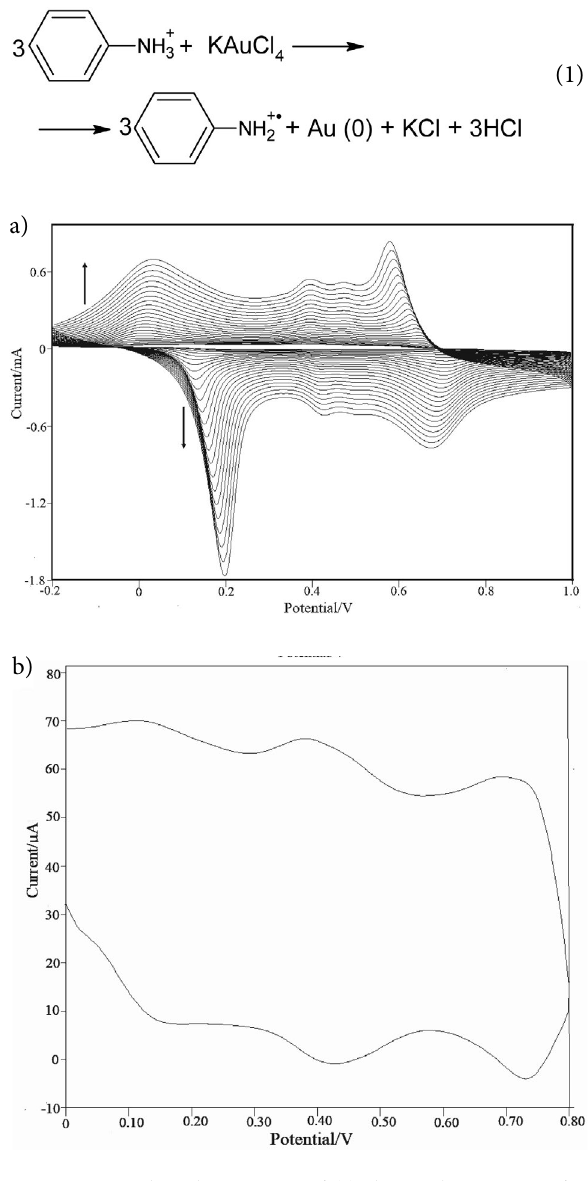
Figure 3. Cyclic voltammogram of (a) electropolymerization of PANI film on Pt electrode in 50 mM aniline in 1 M HCl (b) Au